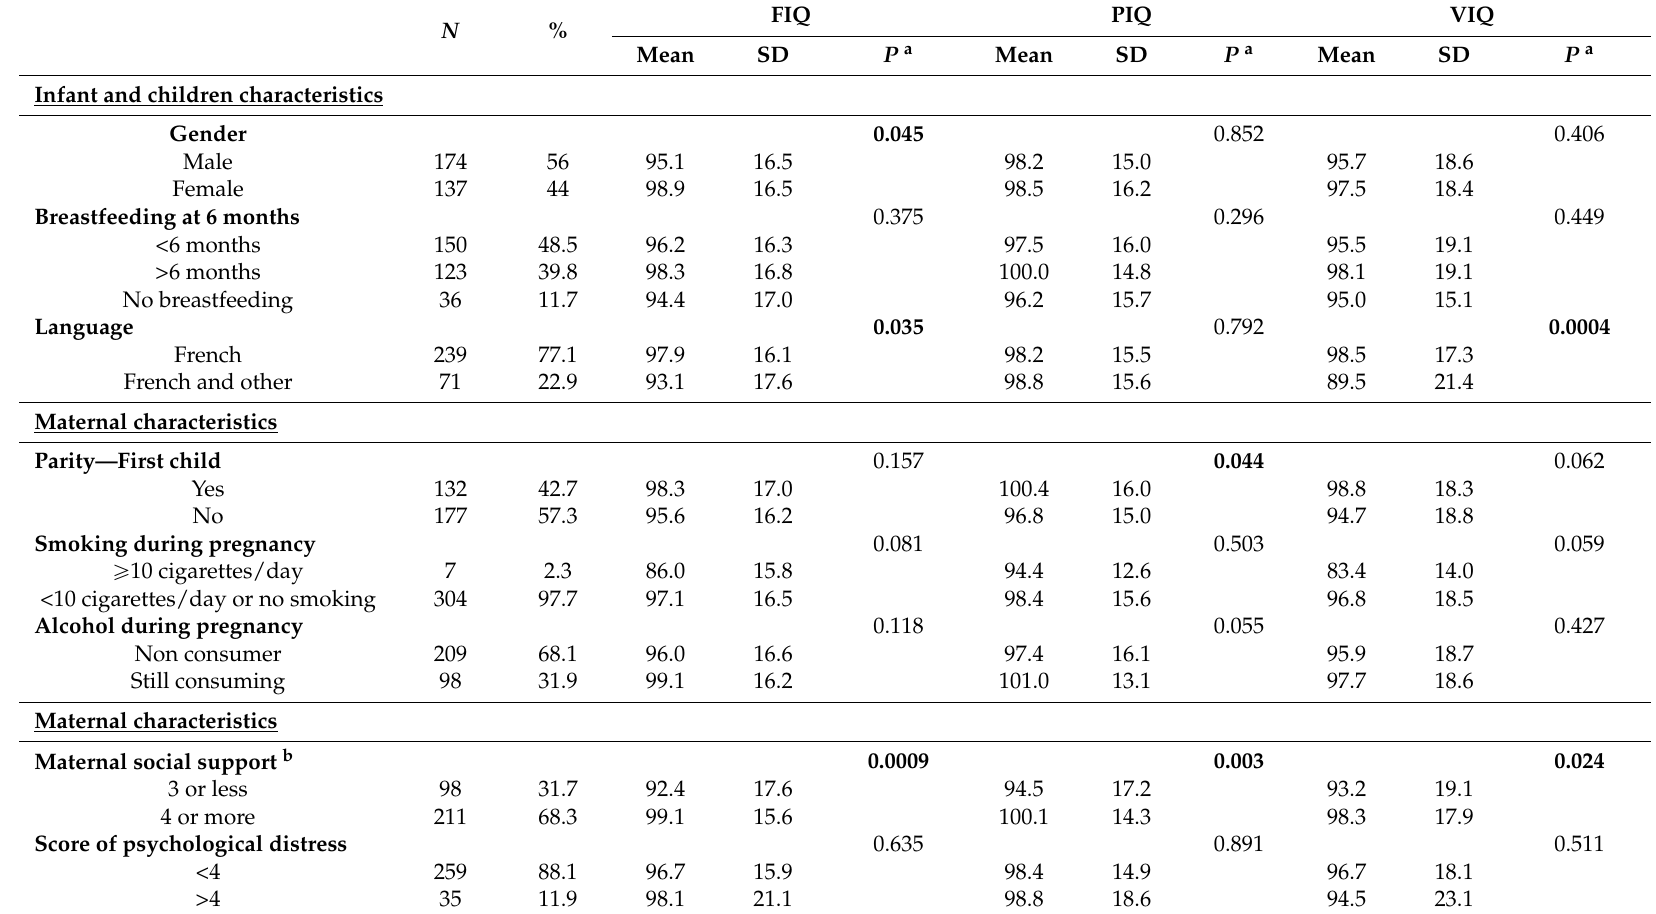
Table 2. Association of cognitive scores of the Wechsler Preschool and Primary Scale of Intelligence at preschool age with infant, maternal, and household characteristics: categorical variables. PsychoTSH study, Belgium,